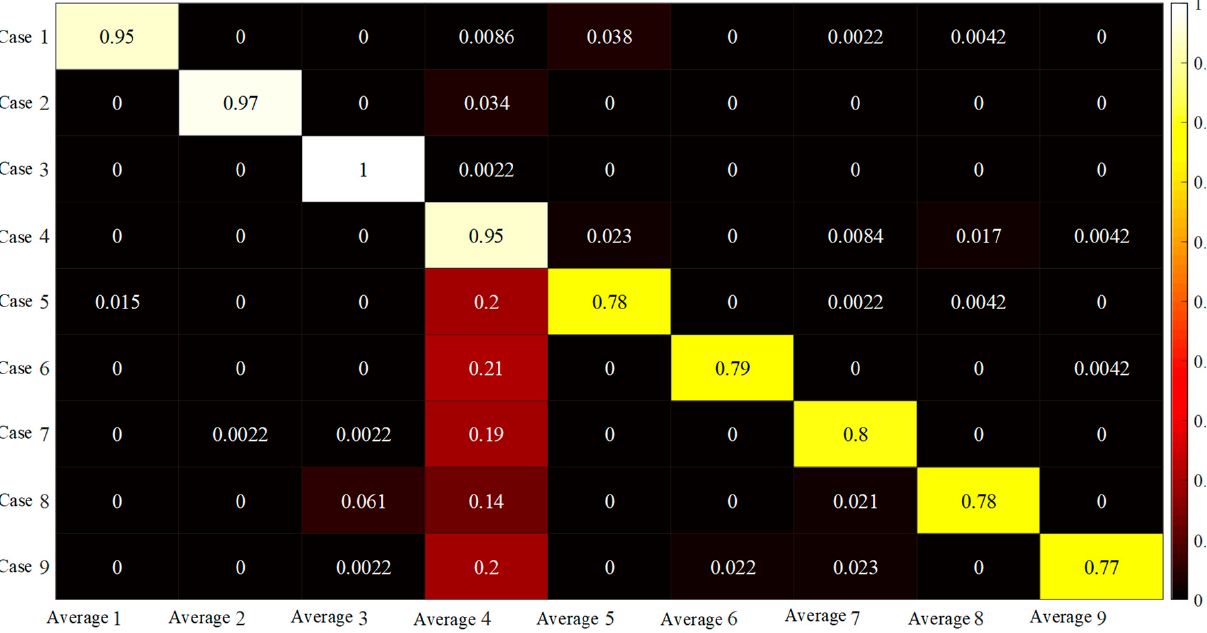
Figure 9. Predicted by 5 BICNN models for 9 damage cases.